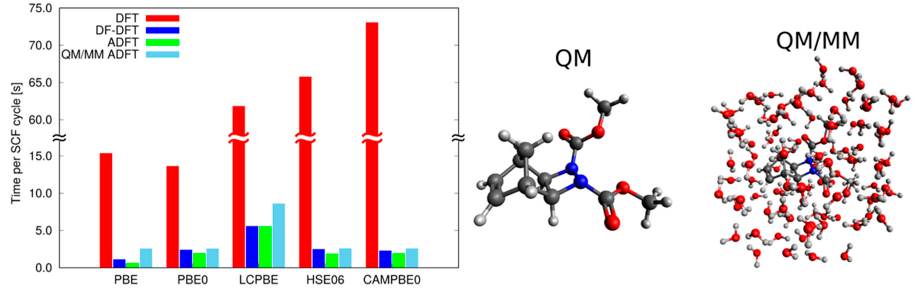
Figure 2. Comparison of Kohn–Sham Density Functional Theory (DFT) self ‐ consistent field (SCF) timings (red) with corresponding auxiliary density functional theory (ADFT) QM (green) and QM/MM (light blue) SCF timings.